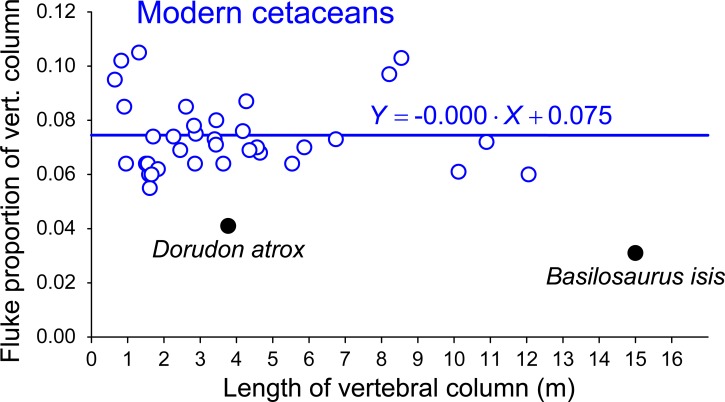
Fluke vertebral length as a proportion of total vertebral column length in cetaceans.Modern species are shown in blue (21 species, N = 36 individuals). Fluke proportions are regressed on their denominators, showing that fluke proportions are independent of vertebral column length. Dorudon atrox has a fluke proportion of 0.041 (4.1%), and Basilosaurus isis has a fluke proportion of 0.031 (3.1%). Both are significantly smaller than the fluke proportion for any modern cetacean. Thus it is questionable whether Dorudon and Basilosaurus were tail-powered swimmers. A small fluke on a relatively long body may have served, initially, as a caudal stabilizer.